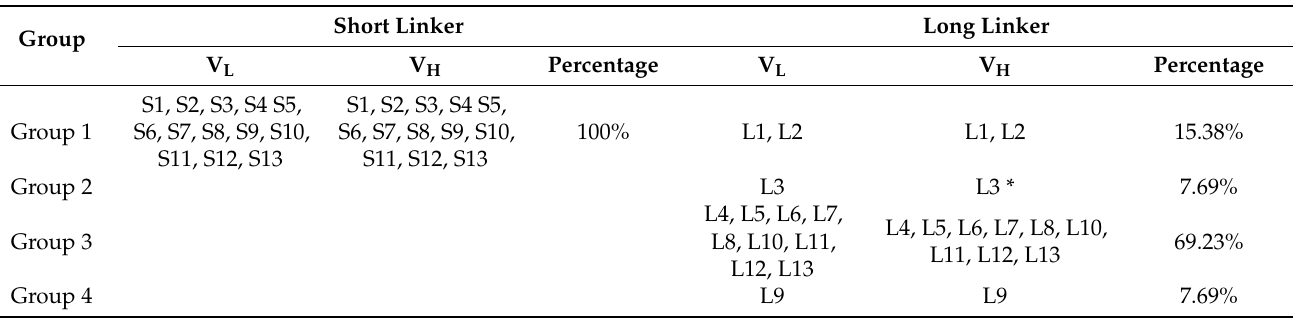
Figure 3. Expression and characterization of scFv antibodies. After bio-panning, 13 randomly selected clones from ( A ) short linker or ( B ) long linker library were induced by IPTG for scFv antibody expression. These expressed scFv antibodies were further confirmed using anti-HA antibody on Western blots. The expression of anti- Coxsackievirus 16 (CA16) S1 scFv antibody was included as a positive control (lane P). ( C ) After sequence analysis and classification, the binding activity of 5 represented clones, EV71S1, EV71L1, EV71L3, EL71L4 and EV71L9 scFv antibodies was tested against the lysate of EV71 infected cells at 1:10 dilution in ELISA. The IgY antibodies from 7th immunized chicken was used as a positive control. ELISA experiments were run in a duplicated manner and statistically analyzed as mean ± SD. Table 1. Grouping of chicken scFv clones according to the identities of V L and V H nucleotide